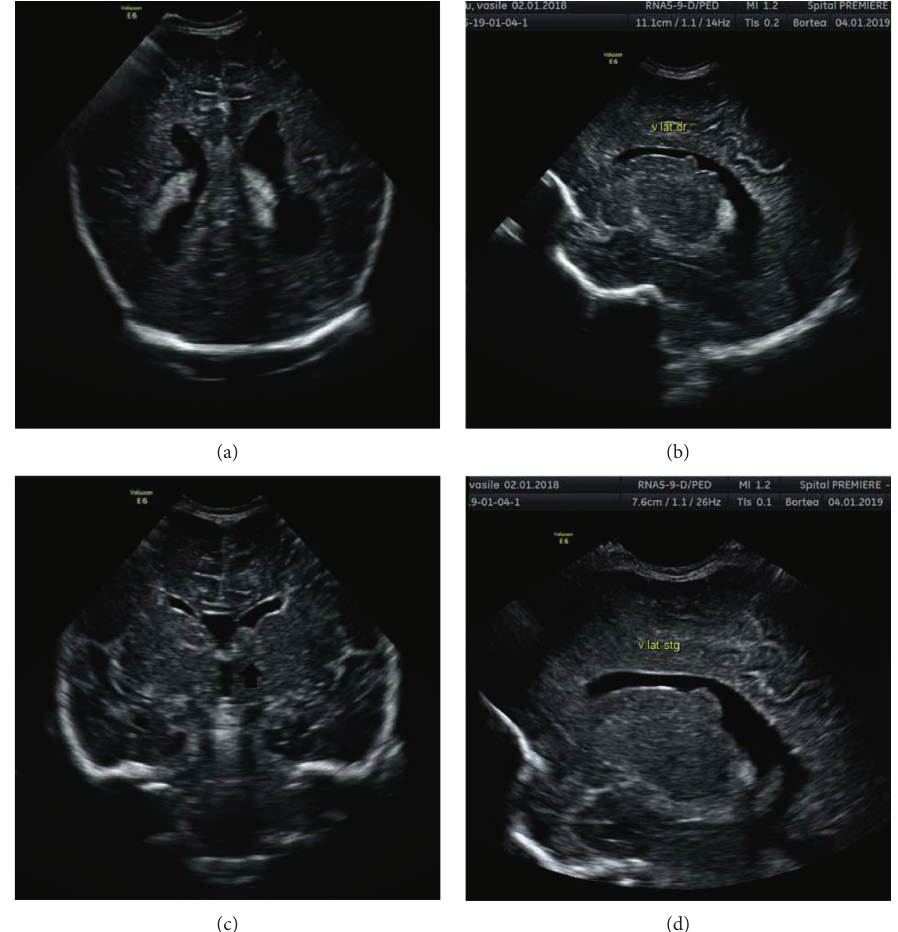
Figure 2: Cranial ultrasound—(a) bilateral hydrocephalus, mostly on the lest occipital horn-posterior coronal section; (b) well-delimitated, irregular, echogenic structures, bumping inside lateral ventricles—right parasagittal section; (c, d) echogenic structures near the left foramen of Monro, with a slight mass effect—coronal section (c) and left parasagittal section